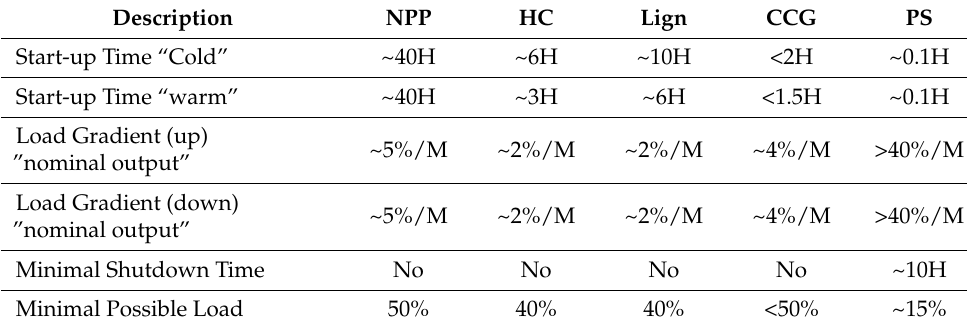
Table 2. Flexibility of Conventional Power Generation